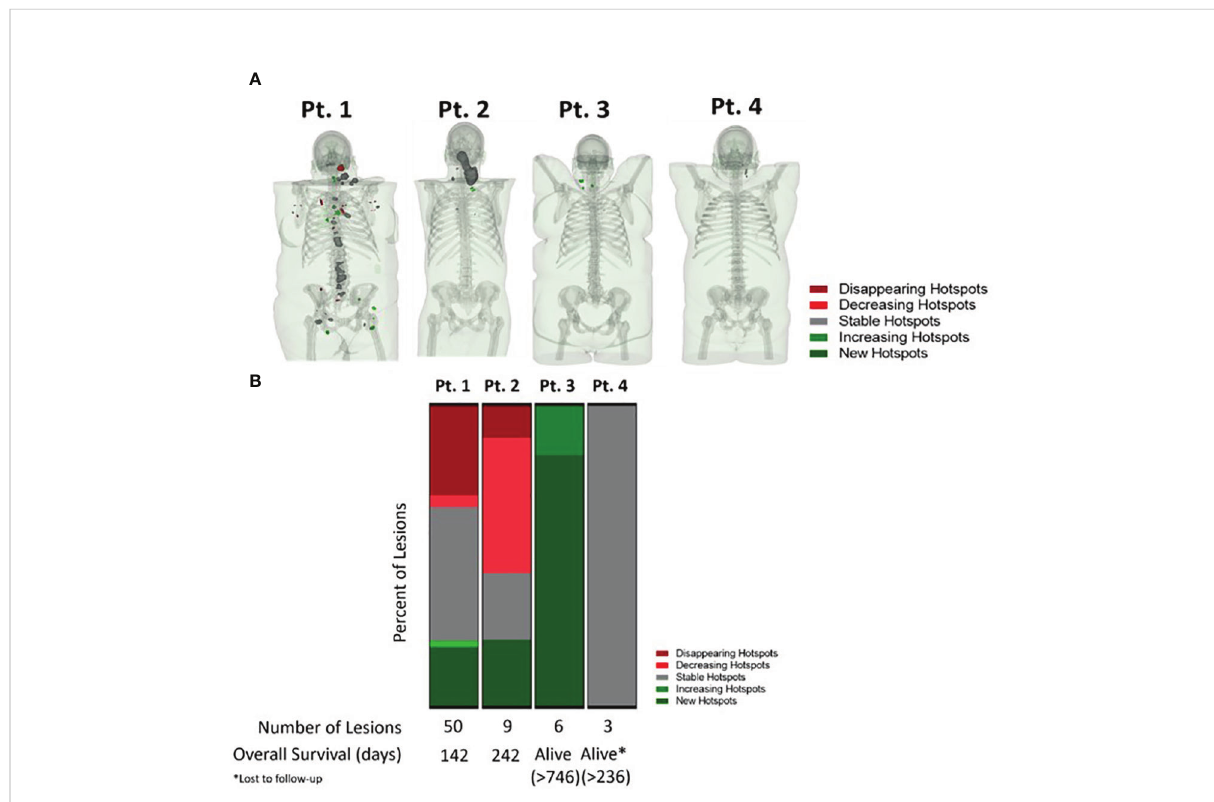
FIGURE 5 AI-assisted whole body evaluation of the change in [18F]F-AraG signal in head and neck squamous cell carcinoma patients. (A) The change in SUV mean in patients pre and post anti-PD-1 therapy. Different colors represent positive (>30% increase in signal, green), negative ( >30% decrease in signal, red) and no change in signal post therapy (within ± 30% signal change range, grey). (B) The [18F]F-AraG signal change post anti-PD-1 therapy trended with patients ’ outcome. The patients with areas where the signal disappeared or decreased post therapy, indicative of the lack of T cell activation, had shorter overall survival than the patients with areas of stable and increasing